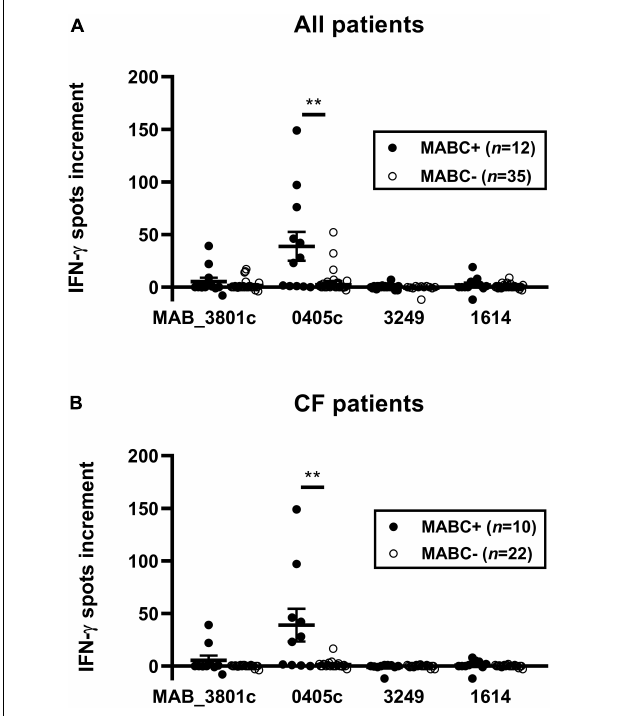
FIGURE 2 | PBMC of patients with and without M. abscessus (MABC) infection were stimulated with the four M. abscessus proteins MAB_3801c, MAB_0405c, MAB_3249, and MAB_1614, and IFN- γ production was determined by ELISpot. We analyzed cellular responses in all 47 patients (A) and separately in 32 patients with cystic fibrosis (CF) (B) , using the optimized cell culture conditions, as defined in Section “Materials and Methods.” Data are indicated as mean and standard error of the mean (SEM). Patients with (+) and without (-) MABC infection were compared by Mann–Whitney U test. Cellular in vitro responses are given as spots increment, i.e., MABC protein stimulated minus negative control. ** p <